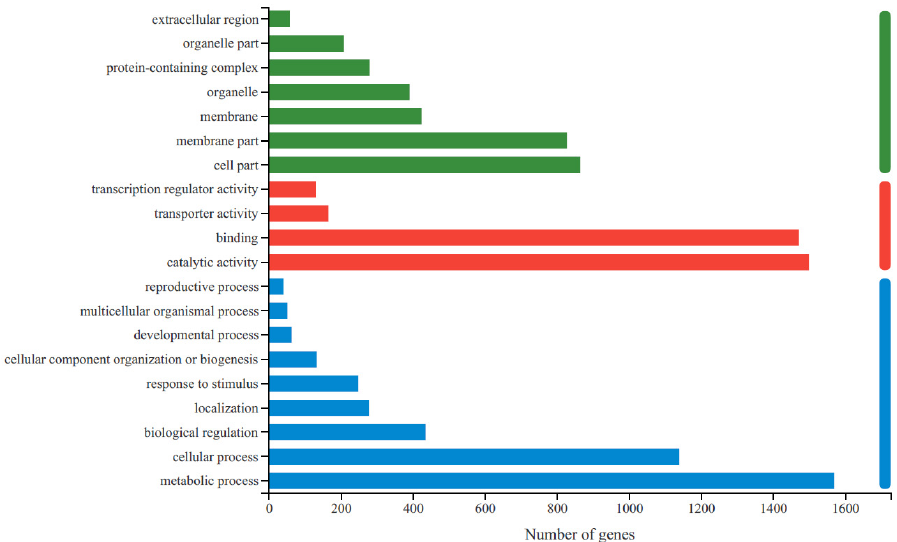
Figure 2. The statistics of GO functional classification of differentially expressed genes (DEGs) in R-HJH compared with HJH. The X-axis indicates the number of DEGs. The Y-axis represents GO terms. All GO terms are grouped into three ontologies: blue represents biological processes, red represents molecular functions and green represents cellular components.